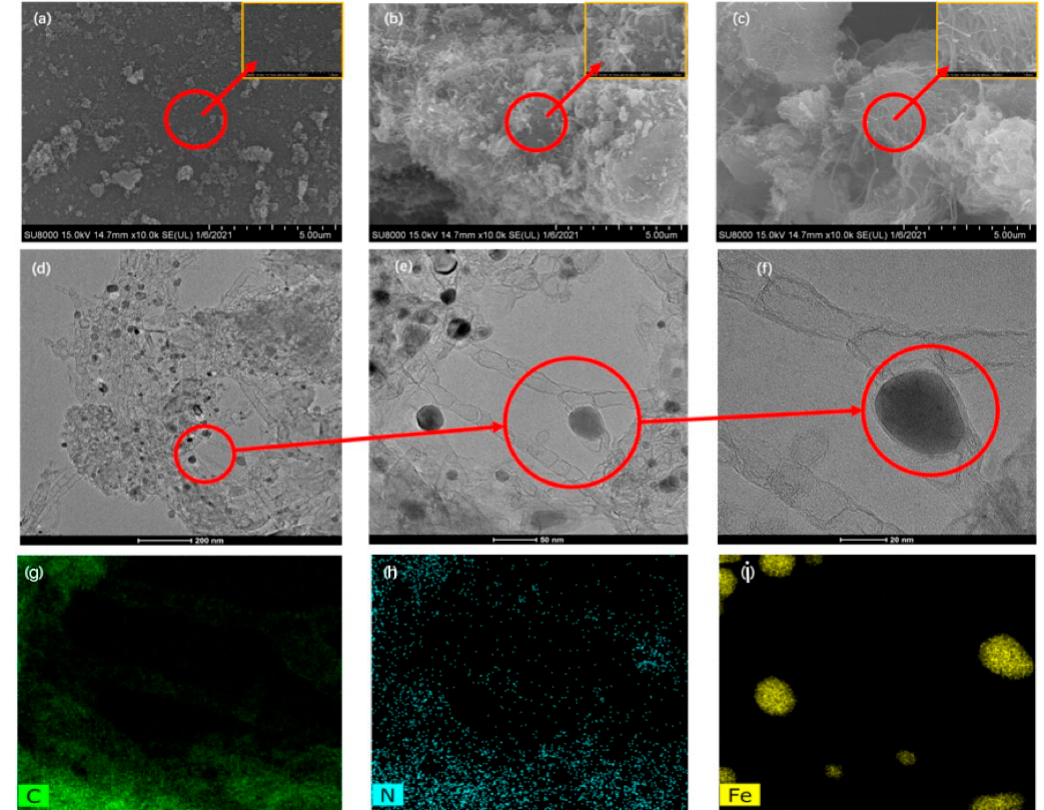
Figure 4. SEM image of ( a )-Fe-C; ( b )-Fe-C-N (D); ( c )-Fe-C-N (M); TEM image of Fe-C-N(M) ( d – i ).